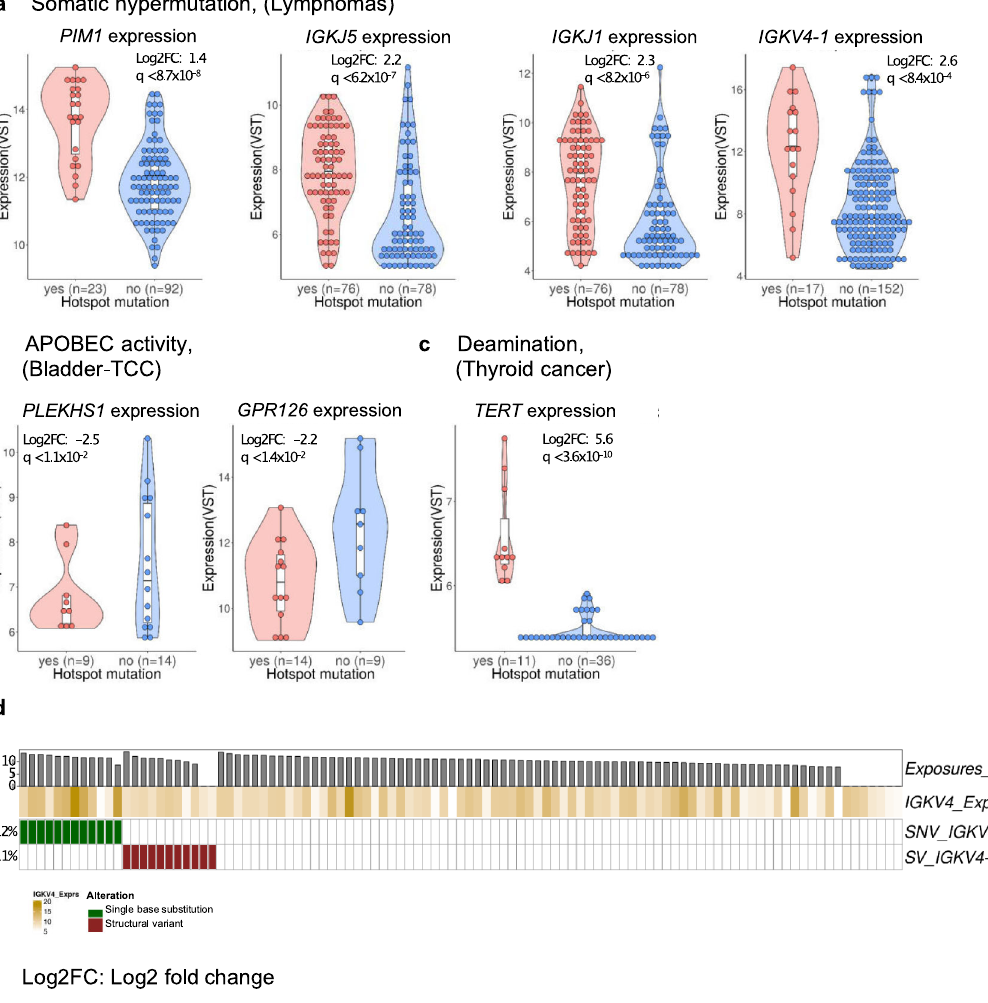
Fig. 5 Gene expression changes related to putative driver hotspots. Signi fi cance and log 2 fold changes for two-sided tests were provided by DESeq2 and presented values are VST transformed. p values were FDR corrected by the total number of expression tests performed on the COSMIC SBS signature set, indicated by the q -values. For details of the hotspots, refer to lollipop plots in the Supplementary Figs. 2, 3, and 7. In the violin plots, the white box indicates the 25th and 75th percentiles with the median highlighted by a black line, whiskers extend to 1.5 times the interquartile range from the 25th and 75th percentiles, and polygons represent density estimates of data and extend to extreme values. a Expression boxplots for PIM1, IGKJ5, IGKJ1, and IGKV4-1 from lymphomas (Lymph-BNHL and Lymph-CLL) associated with somatic hypermutation (SBS84, SBS9), contrasting tumors with and without hotspot mutations. b Expression boxplots for PLEKHS1 and ADGRG6 (GPR126) from bladder cancer (Bladder-TCC) associated with APOBEC activity (SBS2/SBS13). c Expression boxplots for TERT hotspot associated with spontaneous deamination (SBS1). d Oncoprint on mutation status of IGKV4-1 in B-cell non-Hodgkin lymphoma (Lymph-BNHL), describing the relationship between structural variants (SVs) within 200 kb and single nucleotide variants (SNVs) on the hotspot. Source data are provided as a Source Data fi le and in Supplementary Data